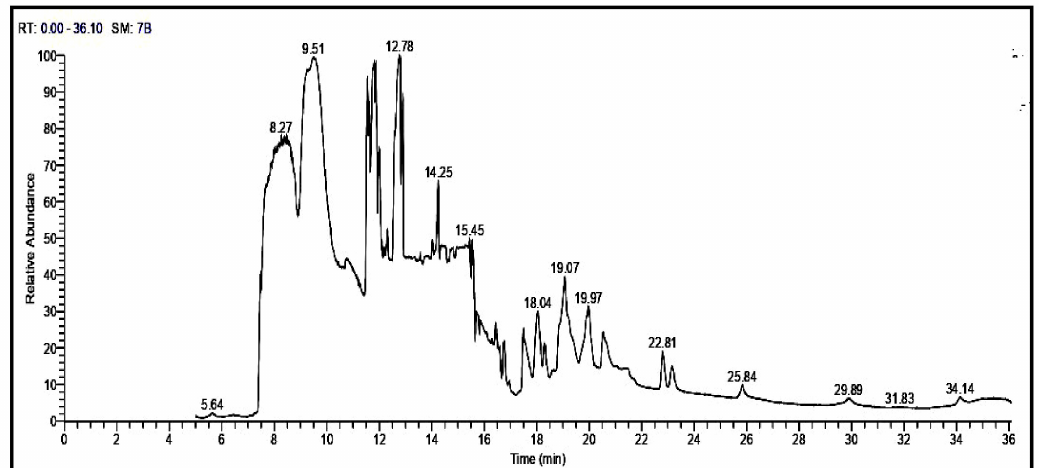
Figure 1. GC-MS analysis of Opuntia ficus-indica seed oil.